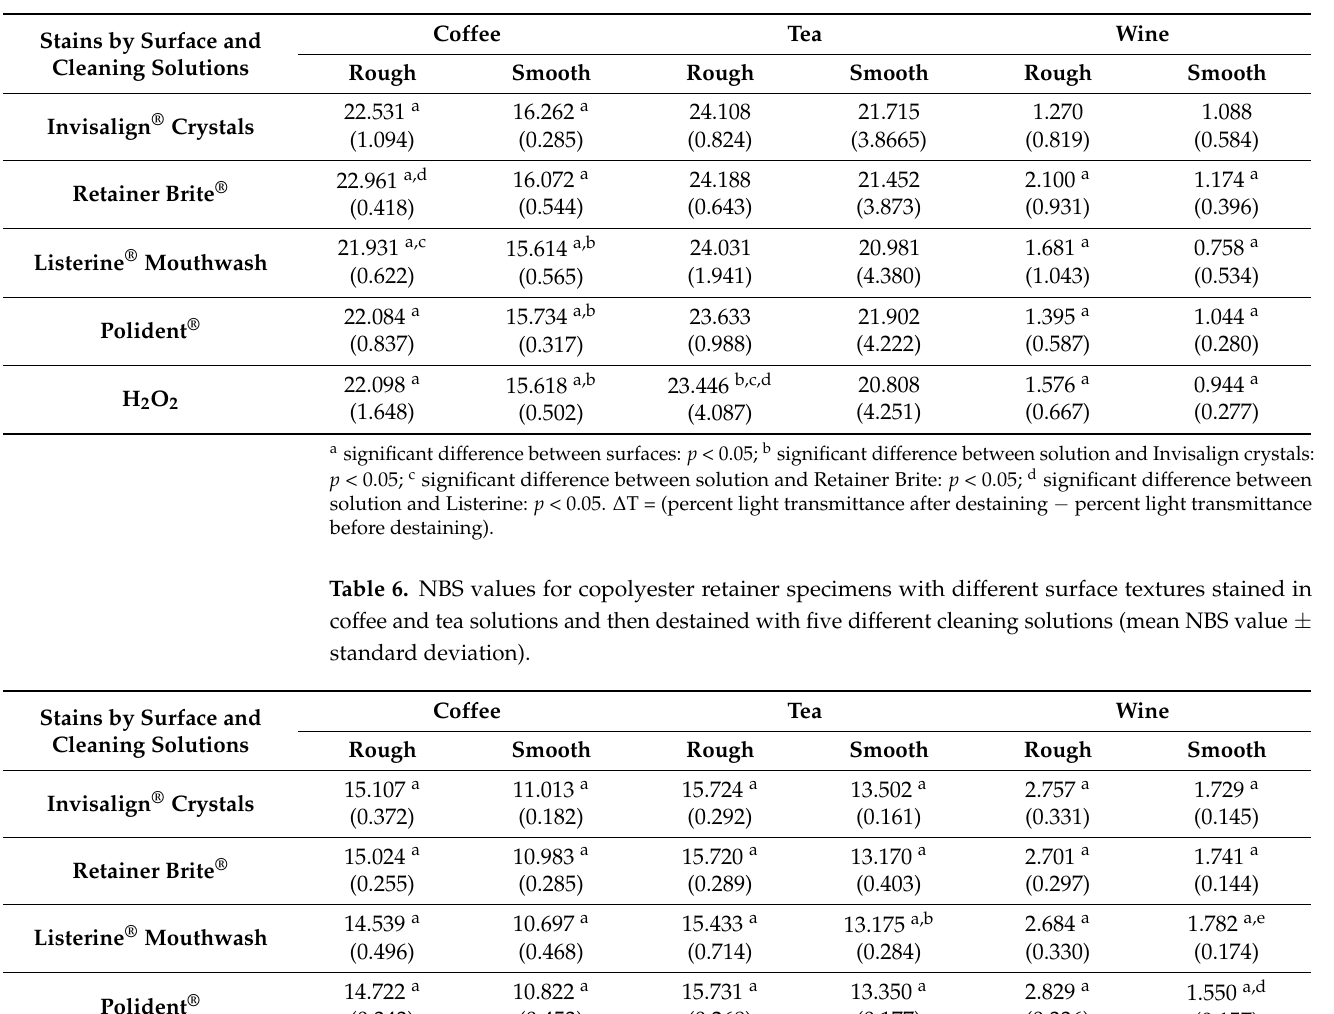
Table 5. Changes in percent light transmittance, ∆ T, for copolyester retainer specimens with different surface textures stained in coffee and tea solutions and then destained with five different cleaning solutions (mean ∆ T value in % ± standard deviation).